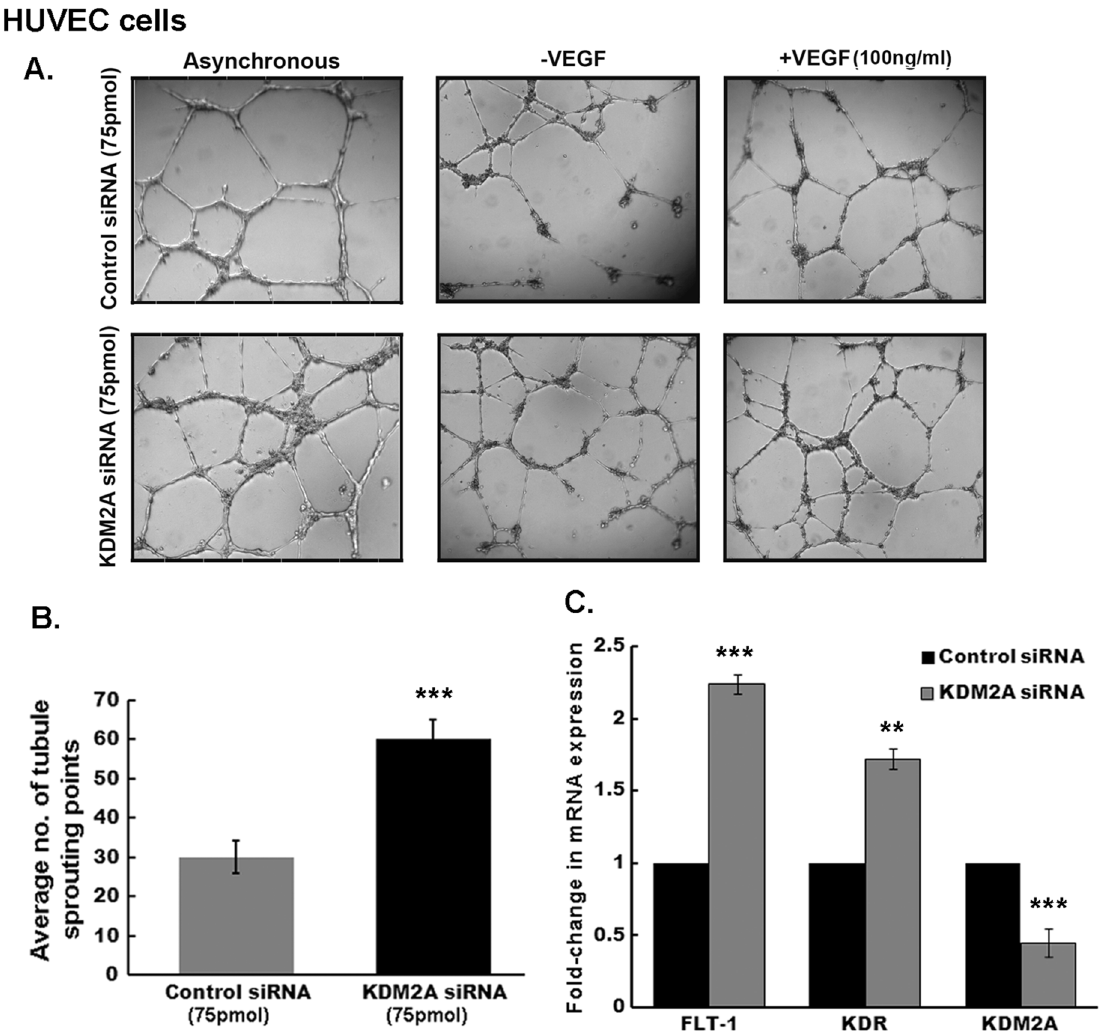
Figure 3. Silencing KDM2A enhances angiogenic tubulogenesis. (A) HUVEC cells were transfected with either control siRNA or KDM2A siRNA (75 pmol). 24 hr later, cells were plated on matrigel in complete media (asynchronous) or with or without 100 ng/ml VEGF. Images were captured 18 hr later using Leica inverted microscope and representative images are shown. (B) Tubule sprouting points were estimated using Image Pro software. Ablation of KDM2A showed significant increase (2-fold, p , 0.01) in the number of sprouting points. (C) Real-Time showing increased mRNA expression of FLT-1 (2.2 6 0.11-fold, p , 0.01) and KDR (1.7 6 0.9-fold, p , 0.05) receptors upon silencing KDM2A expression. Simultaneous decrease in KDM2A mRNA levels (p , 0.01) is seen with 75 pmol of KDM2A siRNA compared to control